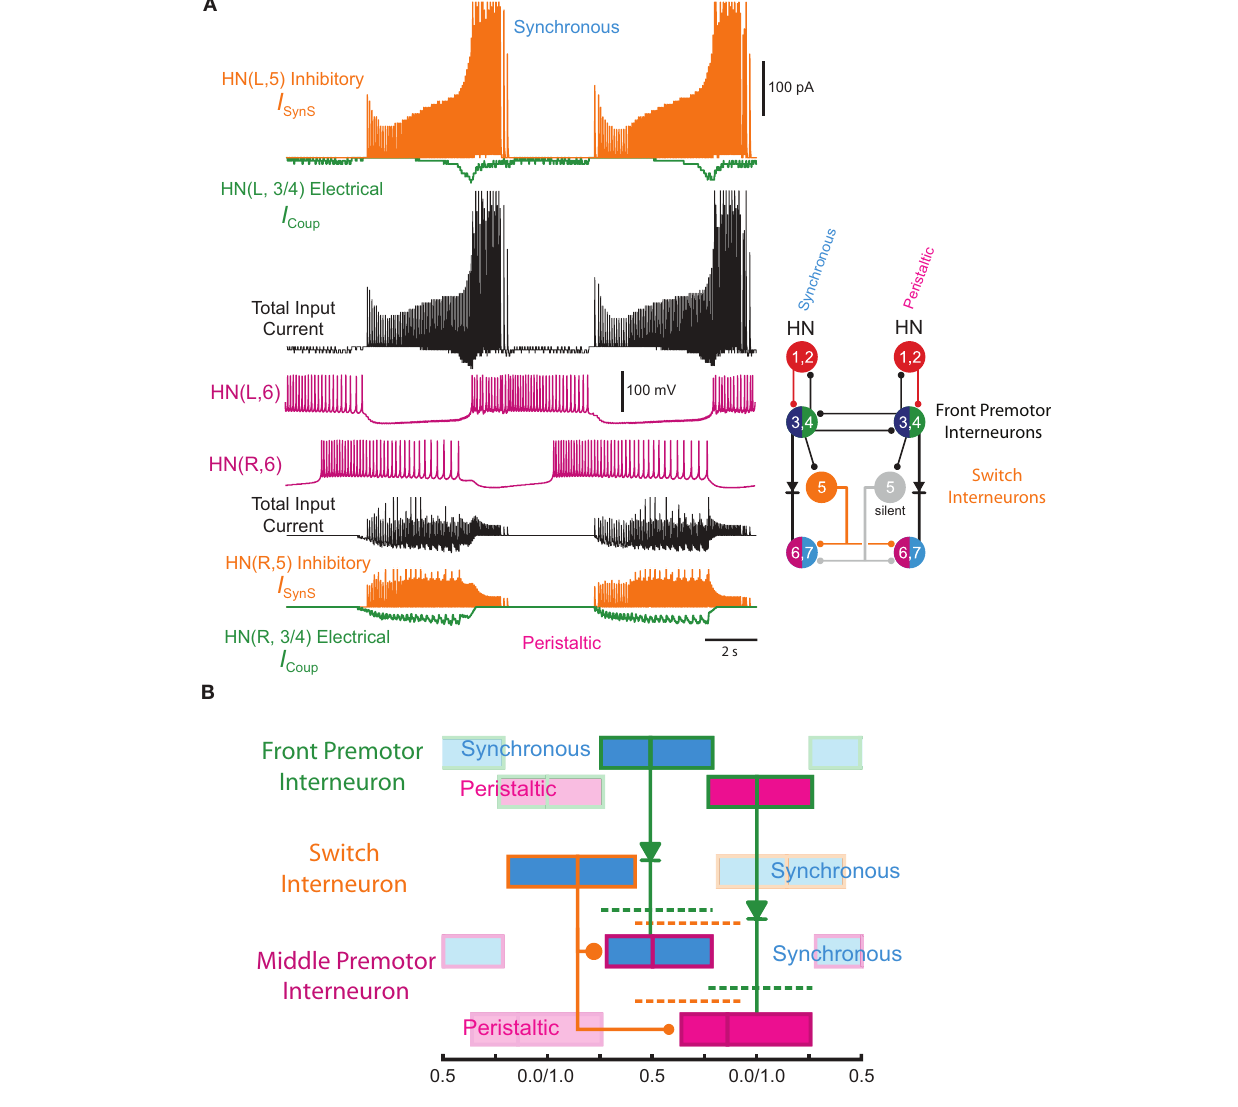
Figure 4B gives a conceptual framework for understanding how this realistic phasing of the middle premotor interneurons is achieved in the CPG model. In the middle premotor interneurons on